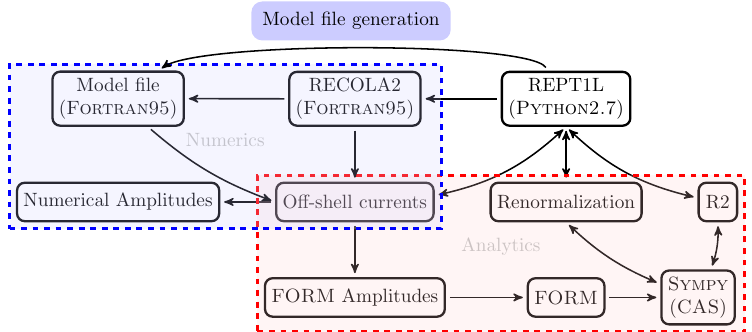
Figure 2. The REPT1L - RECOLA2 tool chain. REPT1L can generate tree-level model (cid:12)les which can then be used in combination with the RECOLA2 library to generate building blocks required in the renormalization process. The process generation is done via the same o(cid:11)-shell currents also used in numerical computations. The currents are evaluated analytically with FORM and further processed with SymPy . The results are then available to REPT1L and are used in the renormalized model (cid:12)le derivation. The red box indicates the analytic computations which uses the tool chain combining RECOLA2 , FORM and SymPy . After the renormalized model-(cid:12)le derivation, this tool chain and REPT1L are no longer needed. The blue box, i.e. RECOLA2